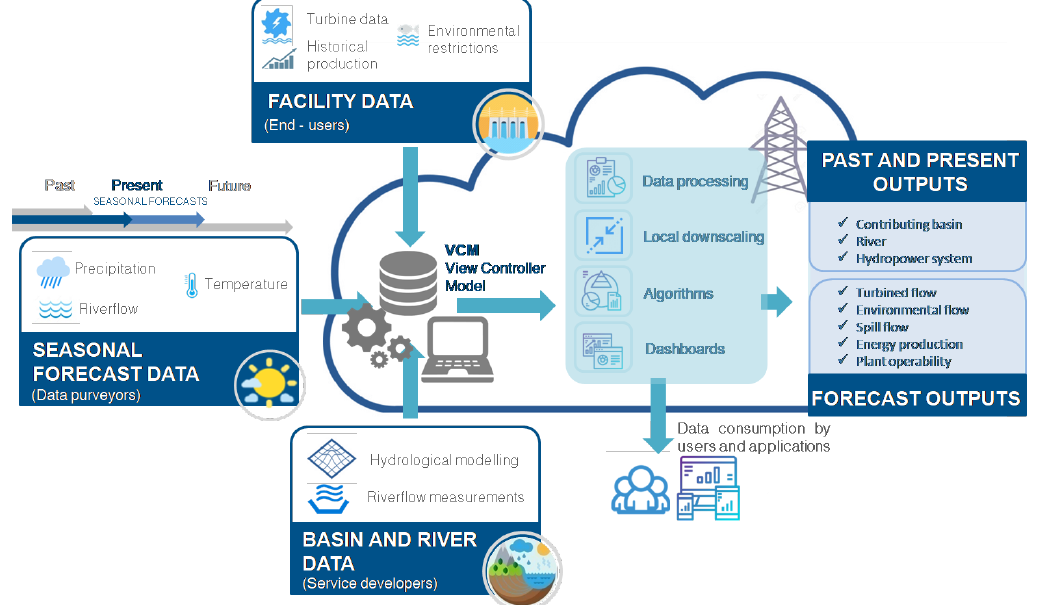
Figure 2. Structure of the CS developed in the CLARA project for the operation of RoR plants (SHYMAT), including the seasonal forecast, facility data, and historical data.